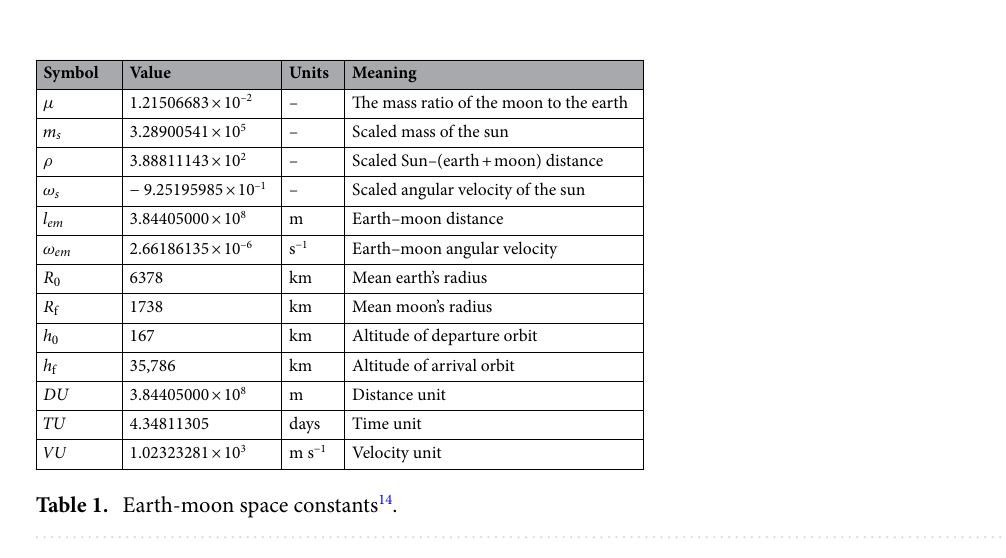
Figure 2. The vectors of the position and velocity at the epoch of trans-lunar injection.